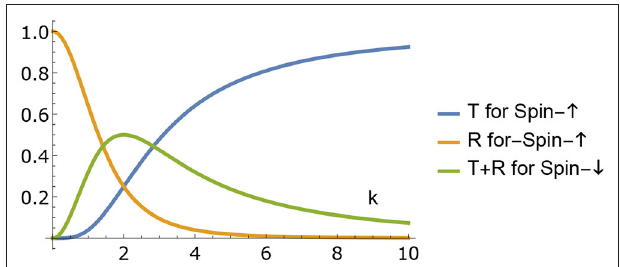
FIGURE 1 | Scattering of